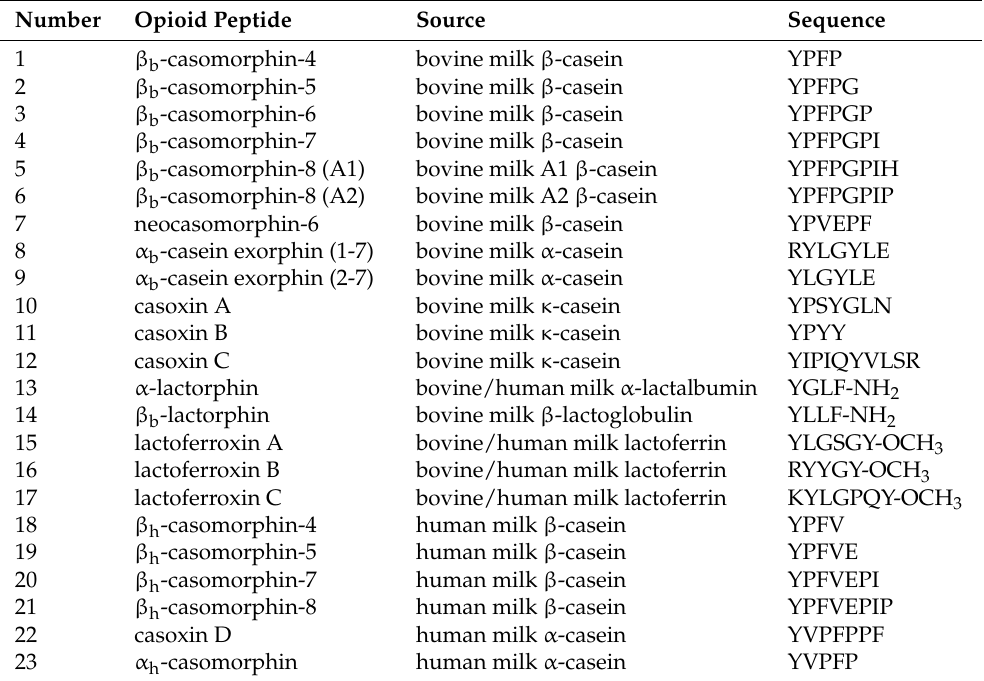
Table 1. List of opioid peptides used in this